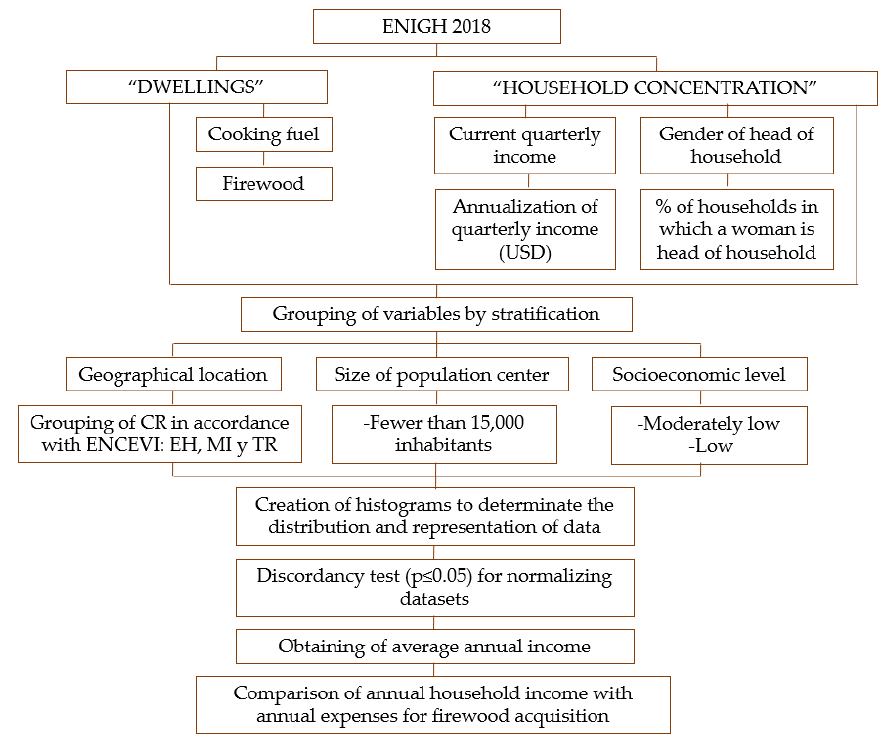
Figure 3. Statistical treatment for determining monetary income of households where firewood is used. Source: Own elaboration.